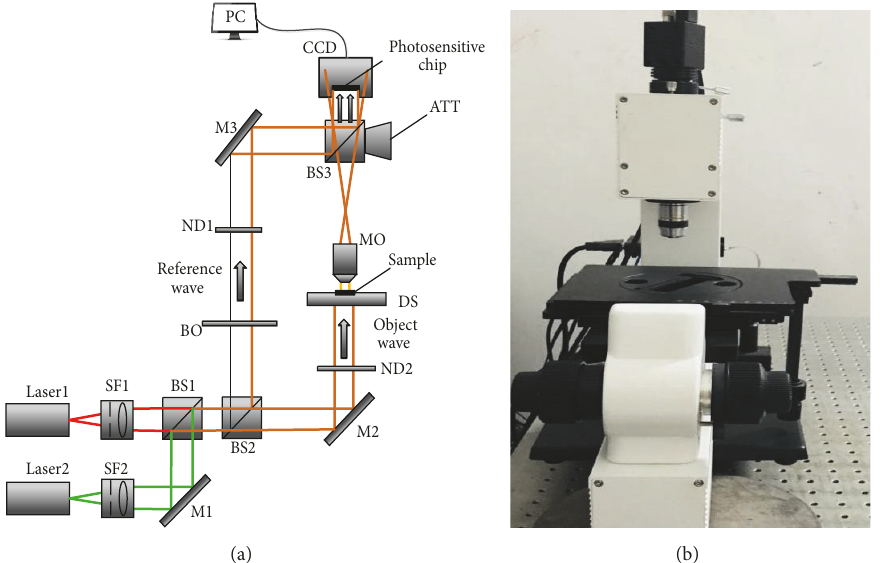
Figure 2: (a) The schematic diagram of the dual-wavelength DHM system. SF, spatial filter; BS, beam splitters; M, mirrors; ND, neutral density; DS, displacement stage; S, sample; MO, microscope objective; ATT, adjustable tilting stage; BO, beam obstacle. (b) Real picture of